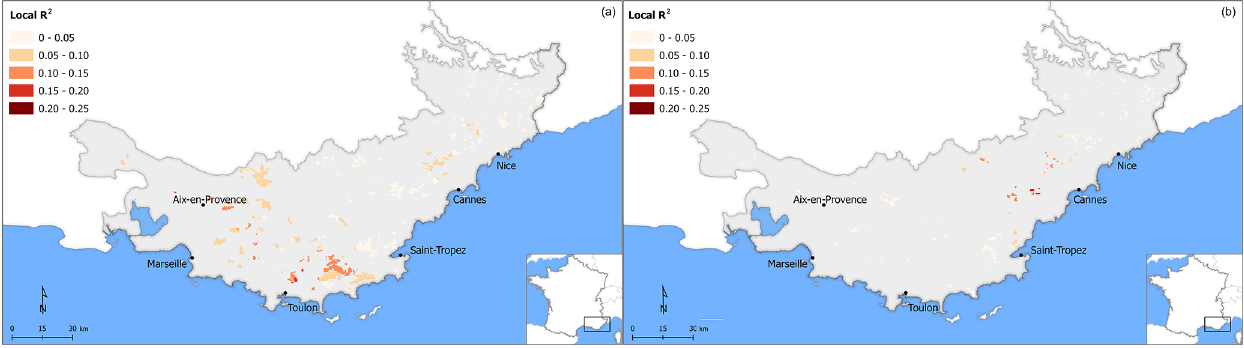
Figure 18. Spatial distribution of local R 2 between the burned area and percent cover of the coniferous forest for 1970–1994 (a) and 1995–2019 (b)